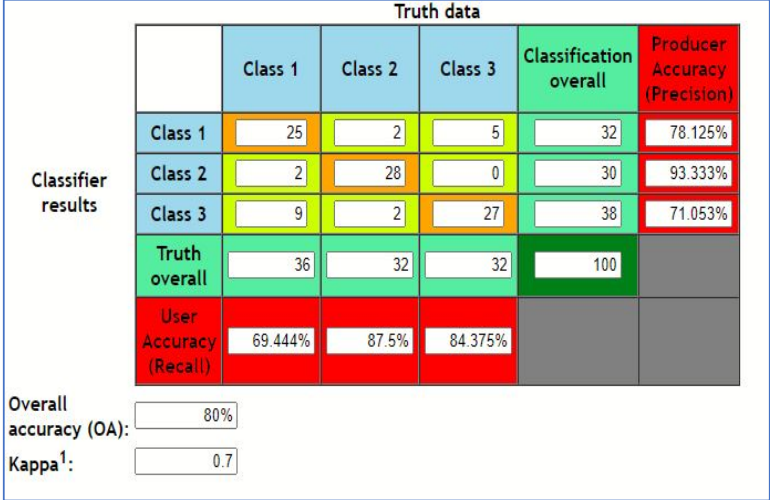
Figure 8. KNN Performance. The accuracy of KNN is 80% as shown in the truth table (Figure 8).